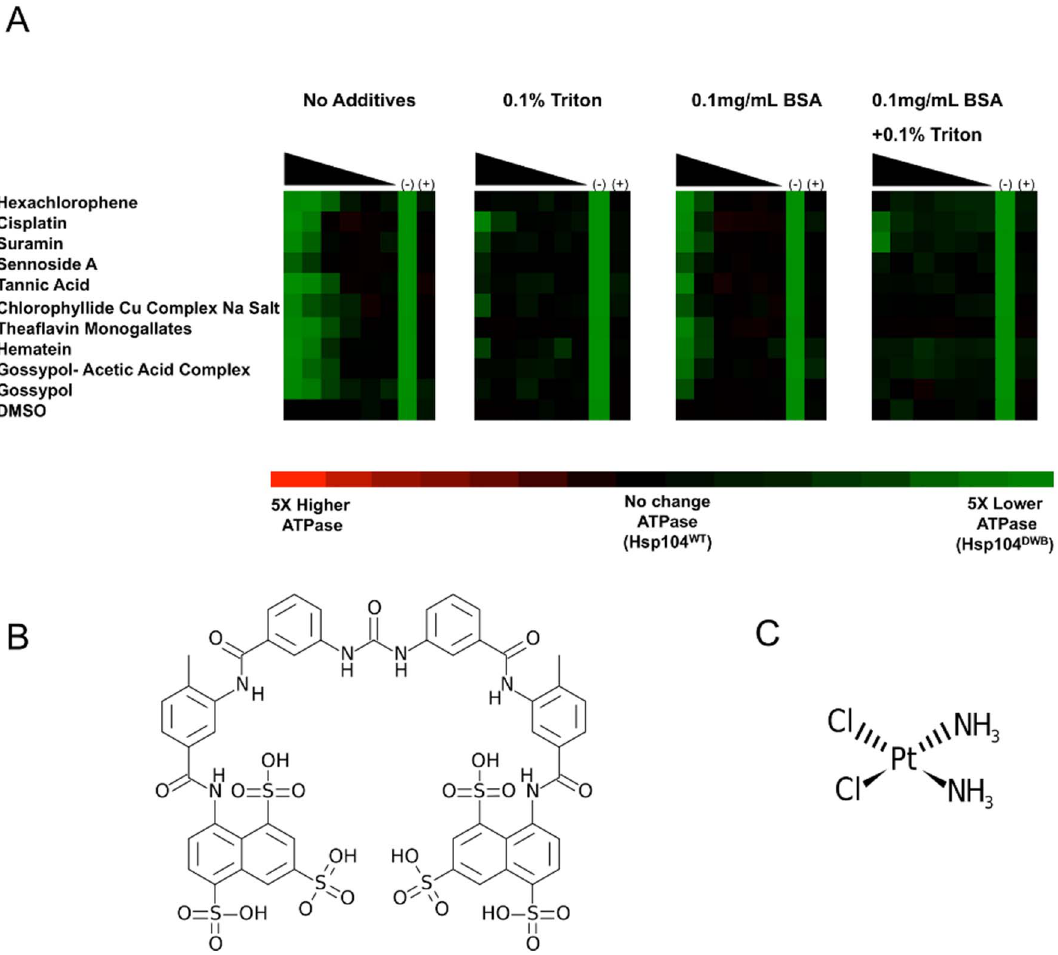
Figure 1. Suramin and Cisplatin inhibit Hsp104 ATPase activity even in the presence of detergent and BSA. ( A ) Hsp104 (0.25 m M monomer) was incubated for 60 min with ATP (1 mM) and varying concentrations (40, 13.3, 4.44, 1.45, 0.49 and 0 m M) of the noted molecules in the presence of Triton X-100 and BSA in the specified concentrations and combinations. The amount of P i produced was measured by absorbance at 635 nm. Raw (non-normalized) absorbance values were transformed to a color scale, where the average absorbance produced by Hsp104 WT is represented as black. The color red represents absorbance values five-fold higher than average absorbance for Hsp104 WT . Green represents absorbance values five-fold lower than the average absorbance obtained for Hsp104 WT . Hsp104 DWB was used as a negative control ( 2 ). Hsp104 WT in the absence of inhibitors was used as a positive control ( + ). ( B, C ) Chemical structures of Suramin ( B ) and Cisplatin ( C ).